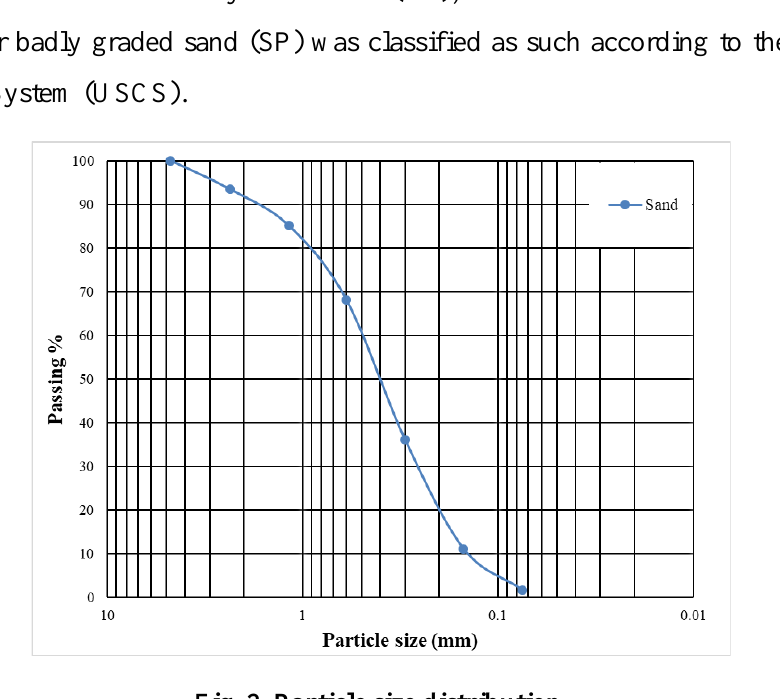
Fig. 2. Particle size